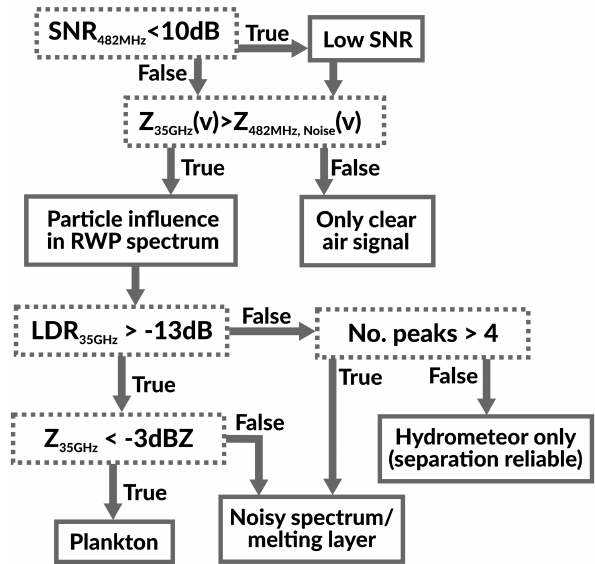
Figure 7. Flow chart of the quality flag decision